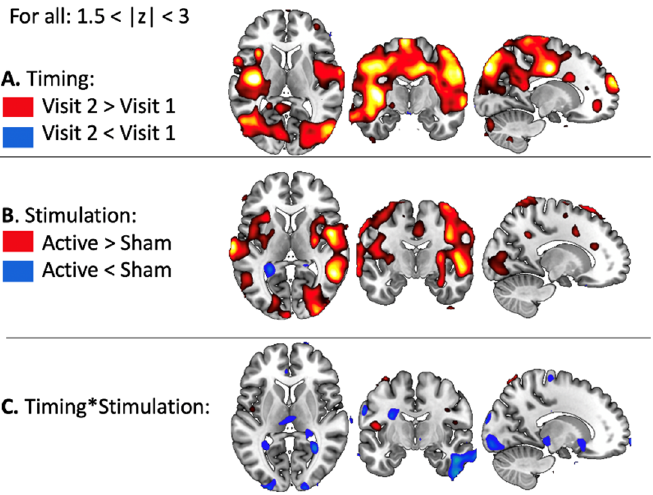
Figure 6. Results from the 2*2 ANOVA on task-related functional connectivity. ( A ) Main effect of Timing (Pre versus Post rTMS). ( B ) Main effect of Stimulation (Active versus Sham rTMS), and ( C ) Interaction between Timing and Stimulation.